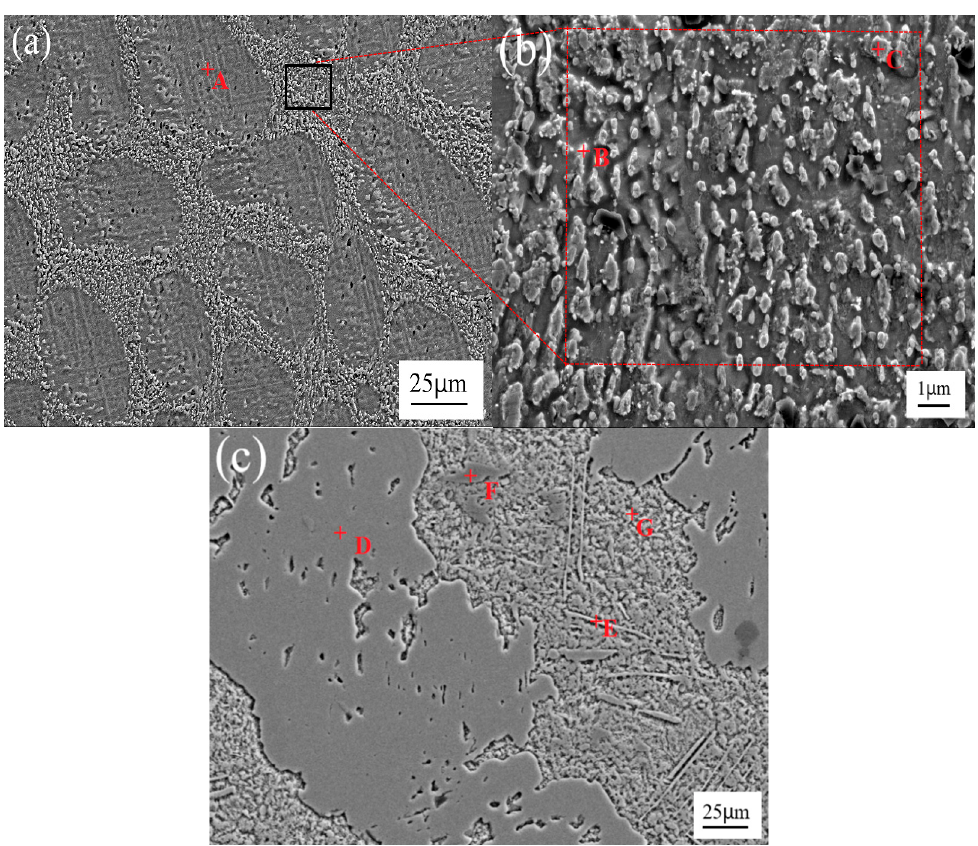
Figure 5. EDS analysis of ( a , b ) Sn-3.0Ag-0.5Cu solder alloy and ( c ) Sn-3.0Ag-0.5Cu-25Sb solder